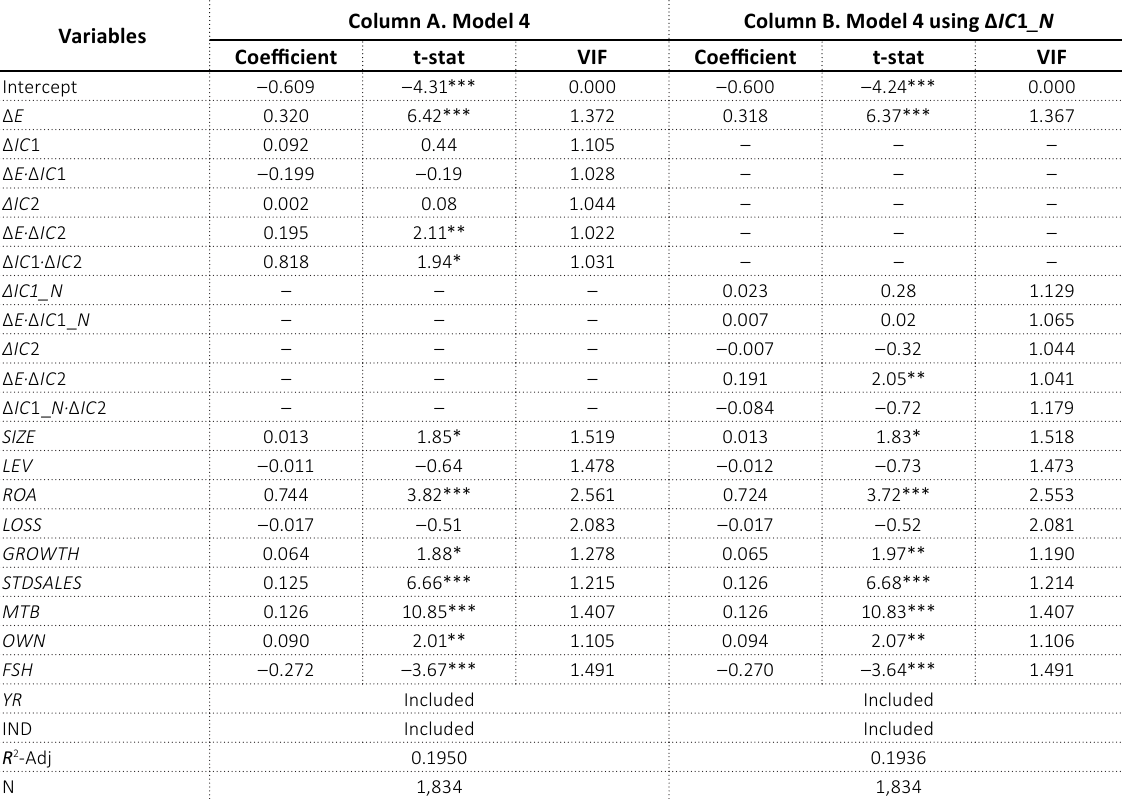
Table 6. Analysis on the effect of IC environment on the value relevance of earnings after controlling for the effect of the quantity and quality of IC personnel on each other